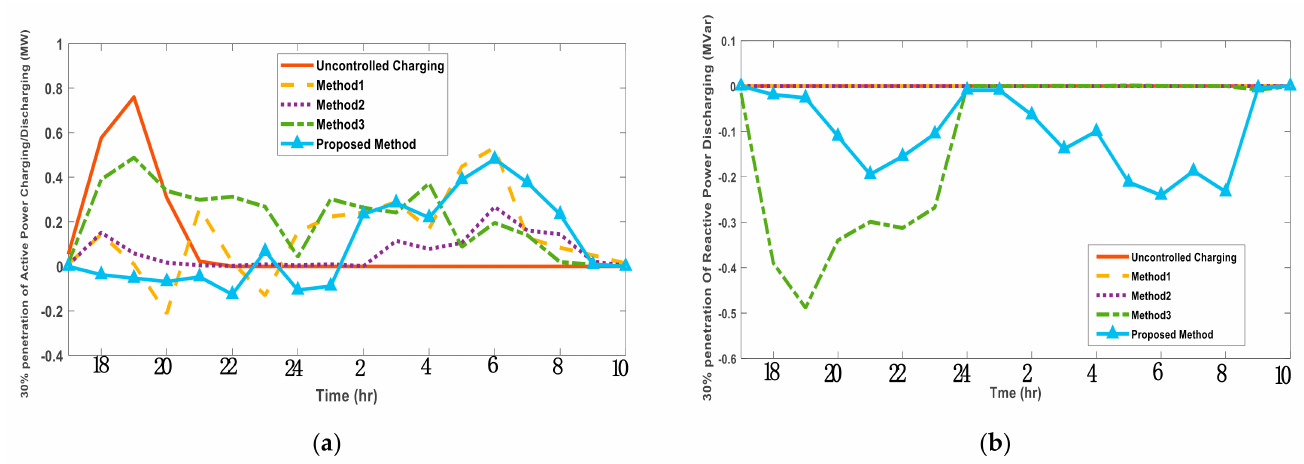
Figure 8. Schedule of ( a ) active power for EVs for different methods; ( b ) reactive power for EVs for different methods under 30% EV penetration.